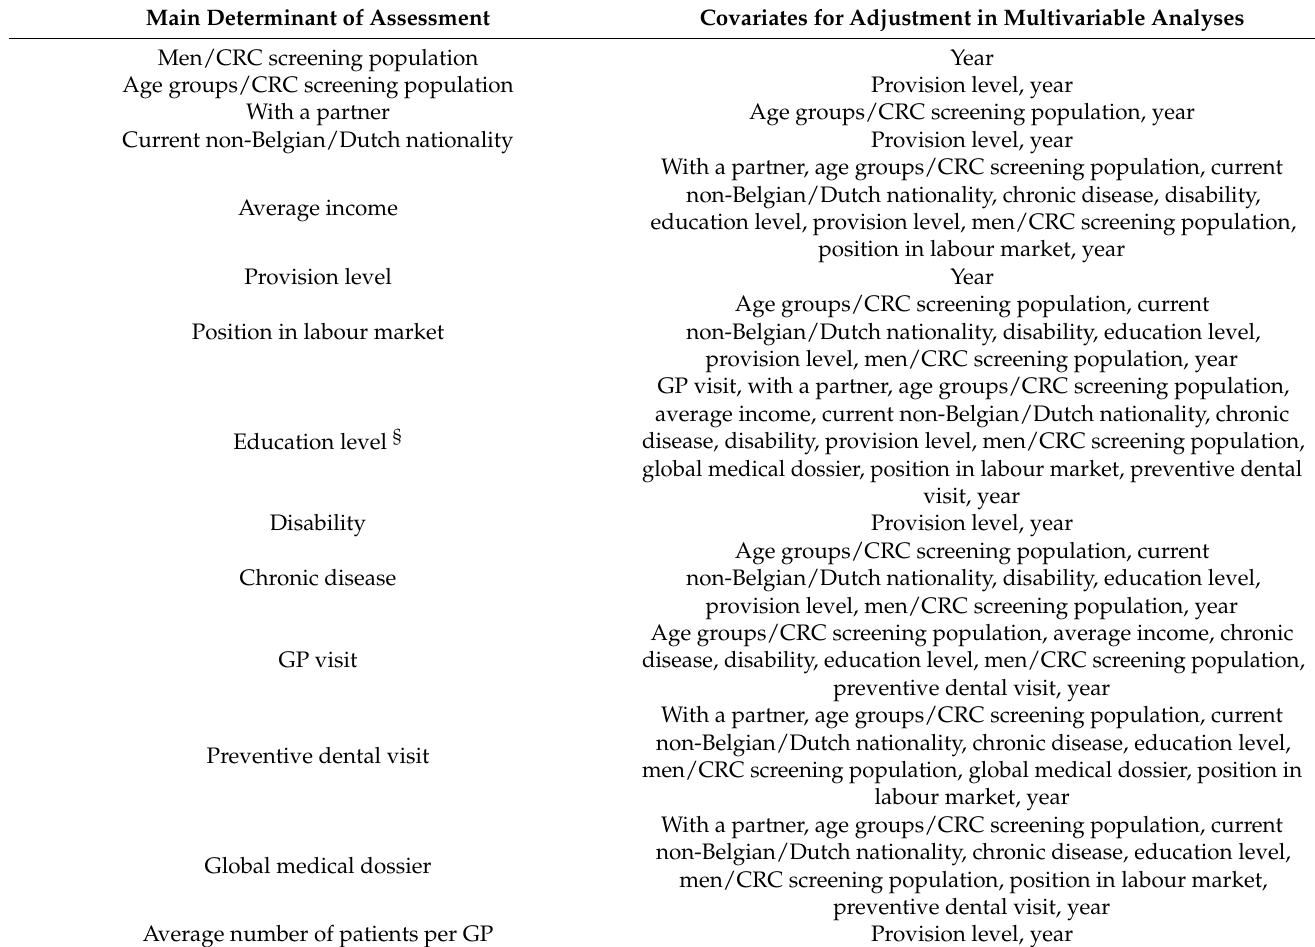
Table 1. List of covariates for adjustment in multivariable analyses to estimate the association between each municipal characteristic (listed under ‘main determinant of assessment’) and organised/non-organised FOBT screening coverages. Main Determinant of